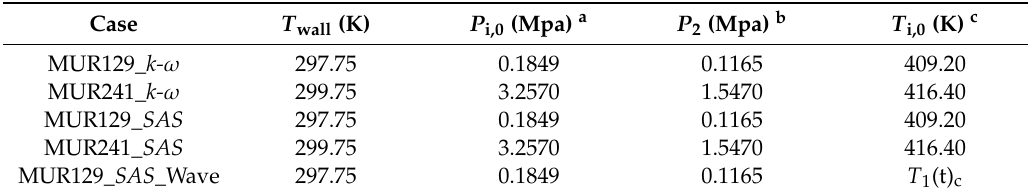
Table 1. Test cases and details of the flow conditions